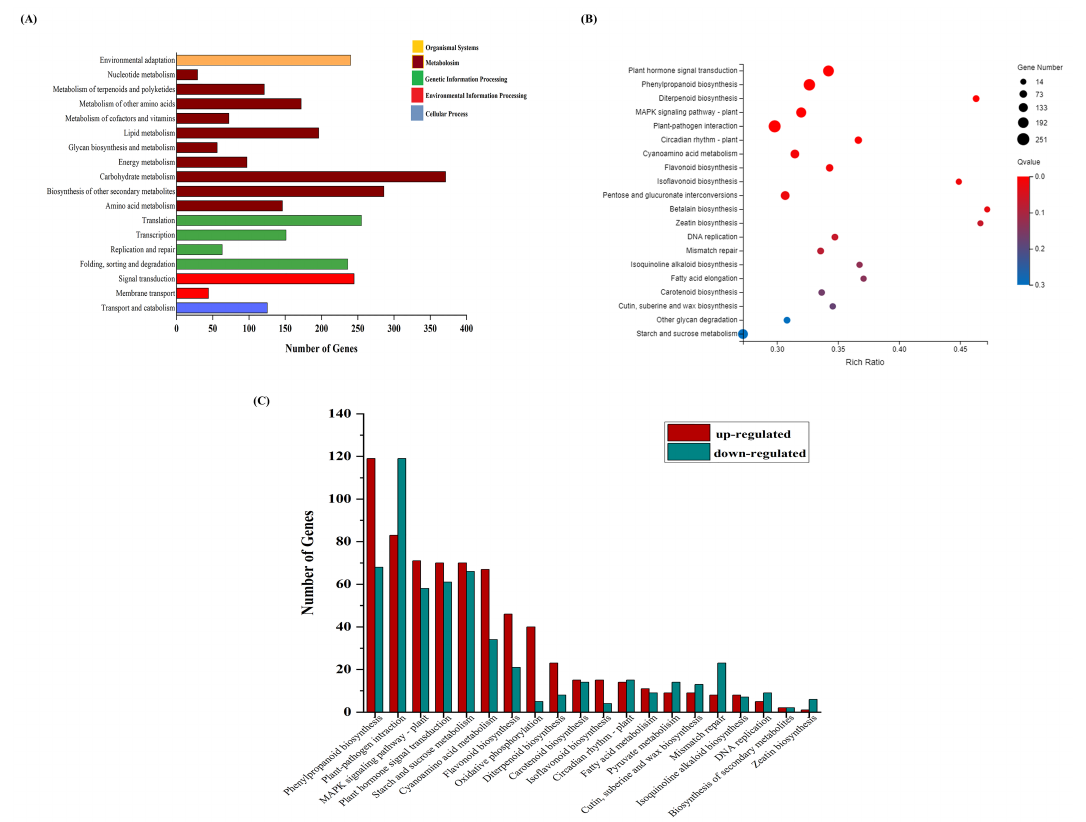
Figure 2. This is a figure, Schemes follow the same formatting. If there are multiple panels, they should be listed as: ( a ) Description of what is contained in the first Figure 3. KEGG pathway enrichment analysis ( A ) DEGs related to significant enrichment analysis were panel. ( b ) Description of what is contained in the second panel. Figures should be placed in the main text near to the first time they are cited. A caption on a single line involved in di ff erent processes ( B ) Bubble plot showing top20 most enriched pathways ( C ) Regulation should be centered. (up / down) trend of the DEGs involved in di ff erent